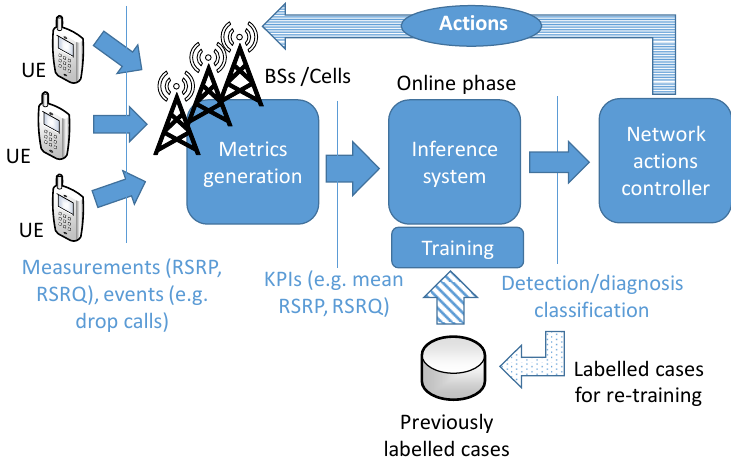
Figure 1. Classic approach for cellular network